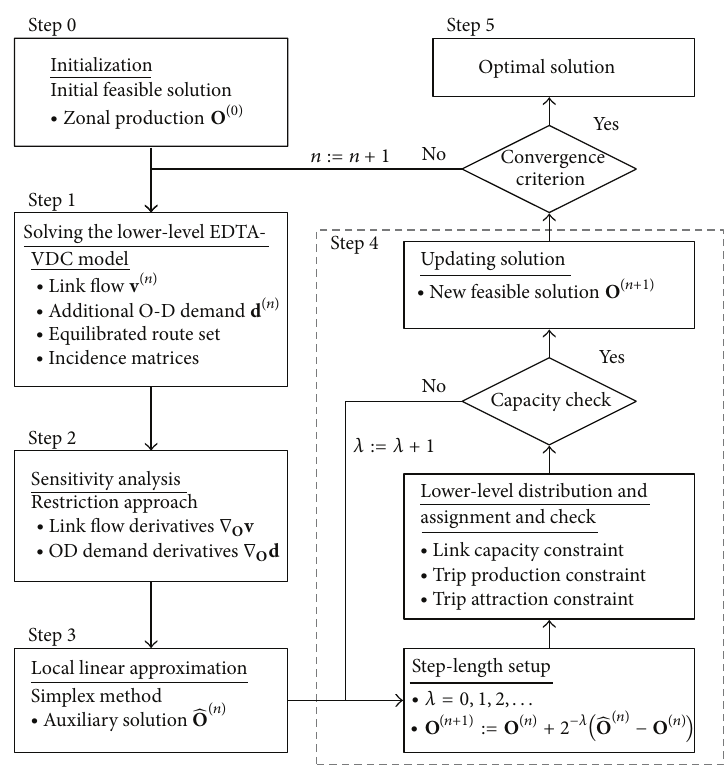
Figure 2: Flowchart of sensitivity analysis based algorithm for network capacity